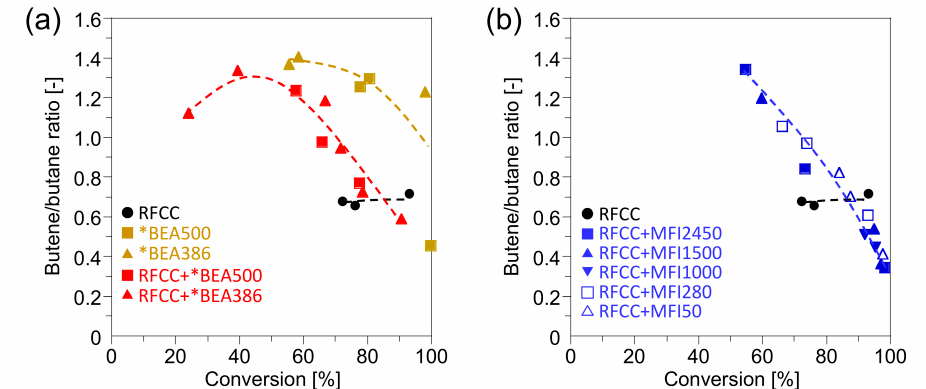
Figure 4. Butene/butane ratio of the reaction product on the composite